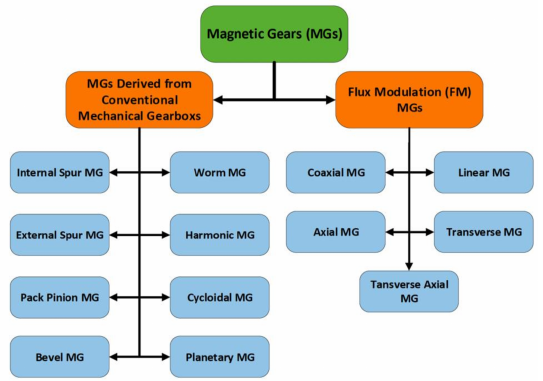
Figure 1. Schematic diagram of Magnetic Gears (MGs)